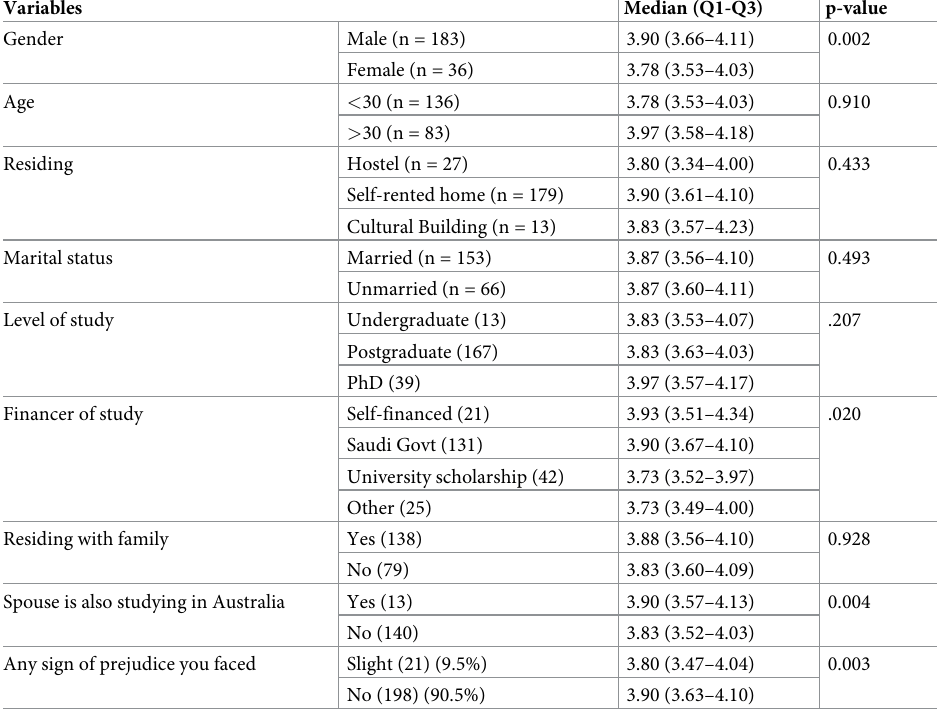
Table 2. Comparison of satisfaction score by study